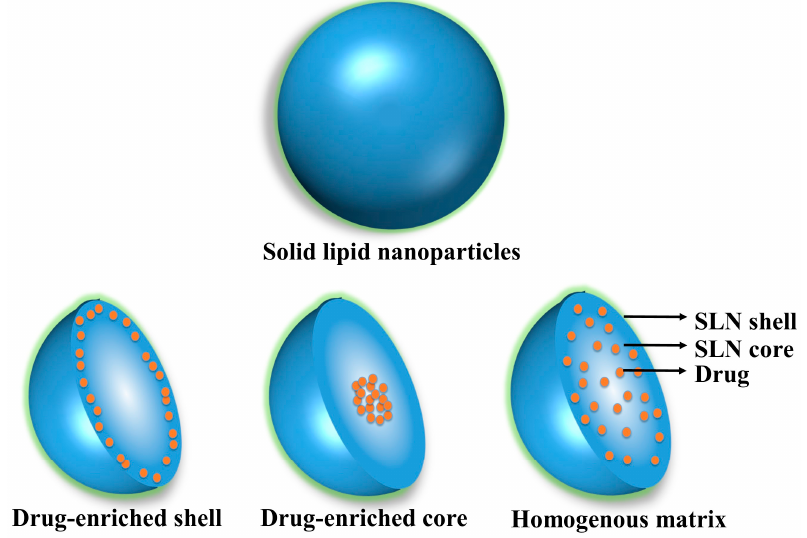
Figure 6. Models of incorporation of active compounds into SLN.